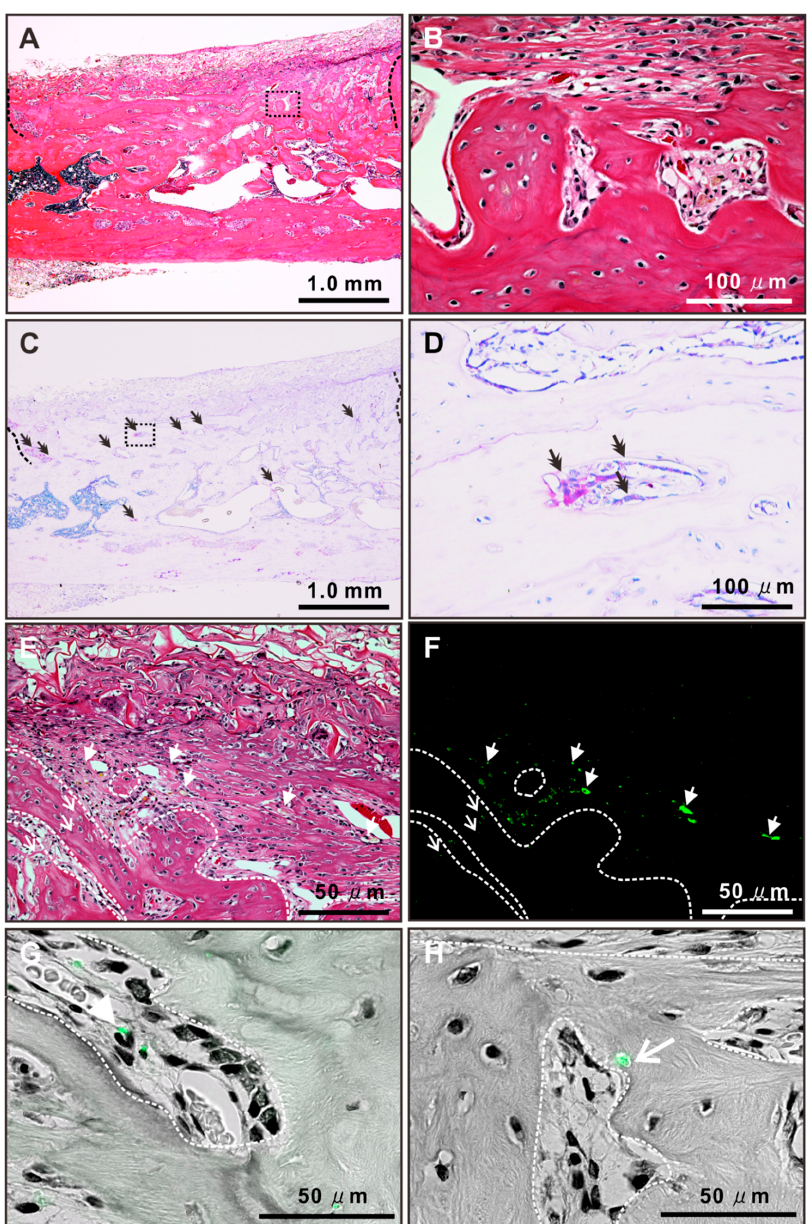
Figure 8. Histological features of newly formed bone tissue after autologous local transplantation of osteoblast-like cells with N -acetyl- L -cysteine (NAC). Representative light-microscope images with hematoxylin and eosin ( A , B,E ) or tartrate-resistant acid phosphatase (TRAP) staining ( C , D ) and fluorescent images merged with ( G , H ) and without ( F ) a light-microscope image in the same region on the histological cross section at the long midline of a 5 × 5 mm defect on the rat femur cortical bone 3 weeks after local transplantation of the collagen sponge vehicle used to load autologous rat osteoblast-like cells pretreated with 5 mM NAC for 3 h. Green in the fluorescent images ( F – H ) indicates transplanted osteoblast-like cells prelabeled with a fluorescent cell tracer. Notes: White arrows: location of green fluorescent signals within newly formed bone tissue; white arrowheads: location of green fluorescent signals on the outside of newly formed bone tissue; double arrow: location of TRAP positive spots; black dashed line: a border between the existing and newly formed bone tissue; white dash line: surface of newly formed bone tissue; black dash square in ( A , C ): the regions corresponding to higher magnification images in ( B , D